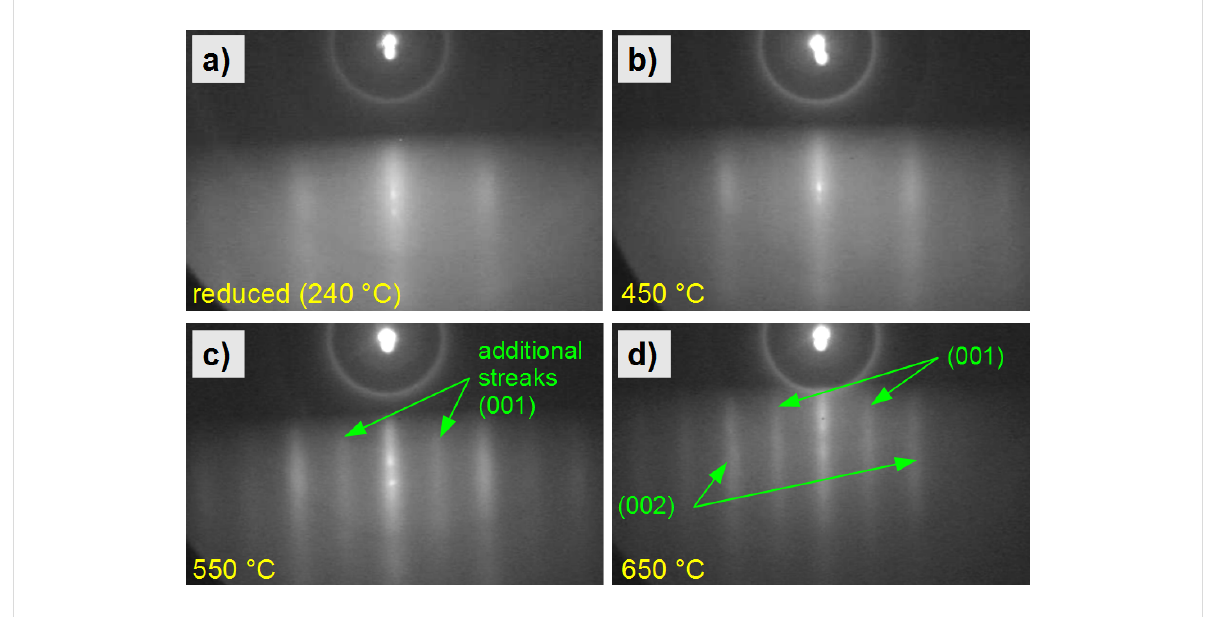
Figure 7: (a–d) RHEED pattern of a FePt film on MgO(100), recorded with an electron beam energy of 25 keV after several annealing steps (each for 30 min) measured under a [100] direction of the incident beam relative to the surface. (a) Broad streaks indicating texture are already visible for the as-reduced film. (c) Additional streaks appear by annealing at 550 °C indicating transformation into the chemical ordered L1 0 phase of the textured domains. (d) Streaks sharpen by annealing at 650